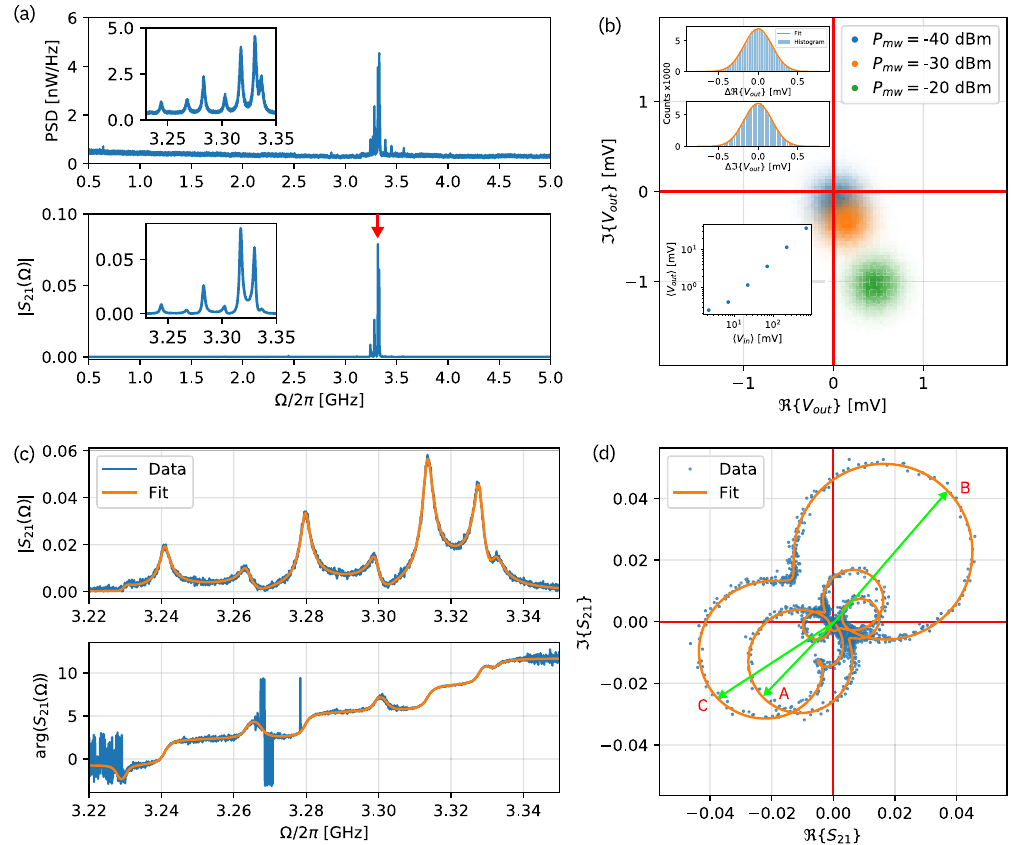
Fig. 5 Microwave-to-optical transduction. a Thermo-mechanical noise power spectral density (PSD) (top) and microwave-to-optical transmission amplitude ∣ S 21 ∣ (bottom). b Quadrature components of the demodulated photoreceiver output voltage distribution V out when the device is driven at 3.317 GHz (indicated by red arrow in the bottom panel of a ) at three microwave powers. For each power level, 10 5 points were collected at a bandwidth of 10 kHz. The insets show histograms of the real and imaginary part of the noise distribution at − 20 dBm along with Gaussian fi ts (upper left) and the average output voltage 〈 V out 〉 versus the average microwave input voltage 〈 V in 〉 (lower left). c Amplitude and phase of the transduced signal versus drive frequency, where the contribution due to cable delay τ has been removed. d In-phase versus quadrature component of the transduced signal. Actuation at the measured eigenfrequencies of the dominant modes is indicated by green phasors, with the assignment to the modes shown in Fig. 1k indicated by A, B, and